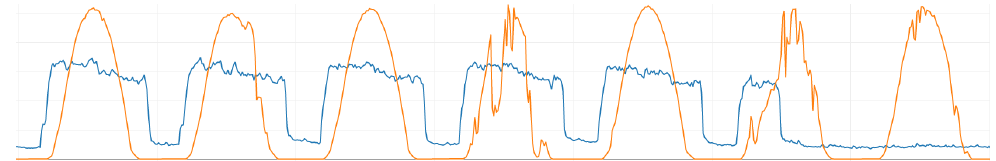
Figure 2. Data samples for the industrial energy consumption profiles (blue) and dome shaped PV production profiles